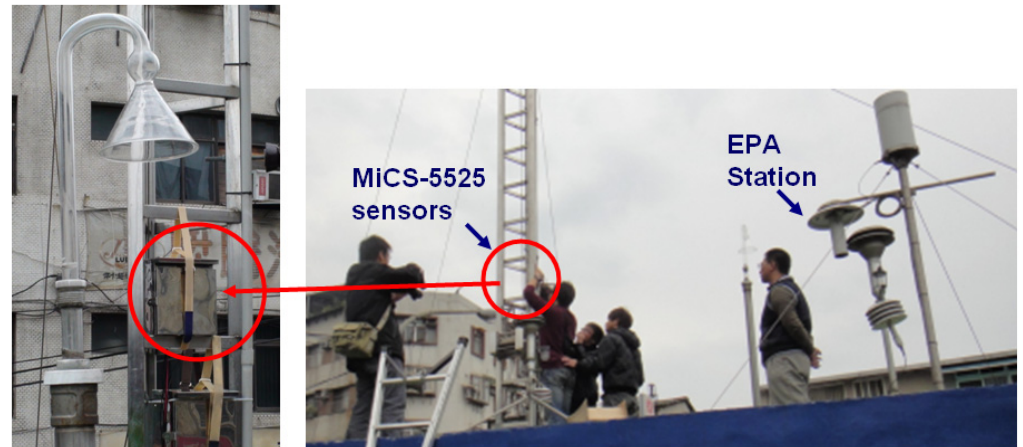
Figure 4. Settings of MiCS-5525 sensors at an EPA station for calibrating CO concentration before deploying wireless sensors.